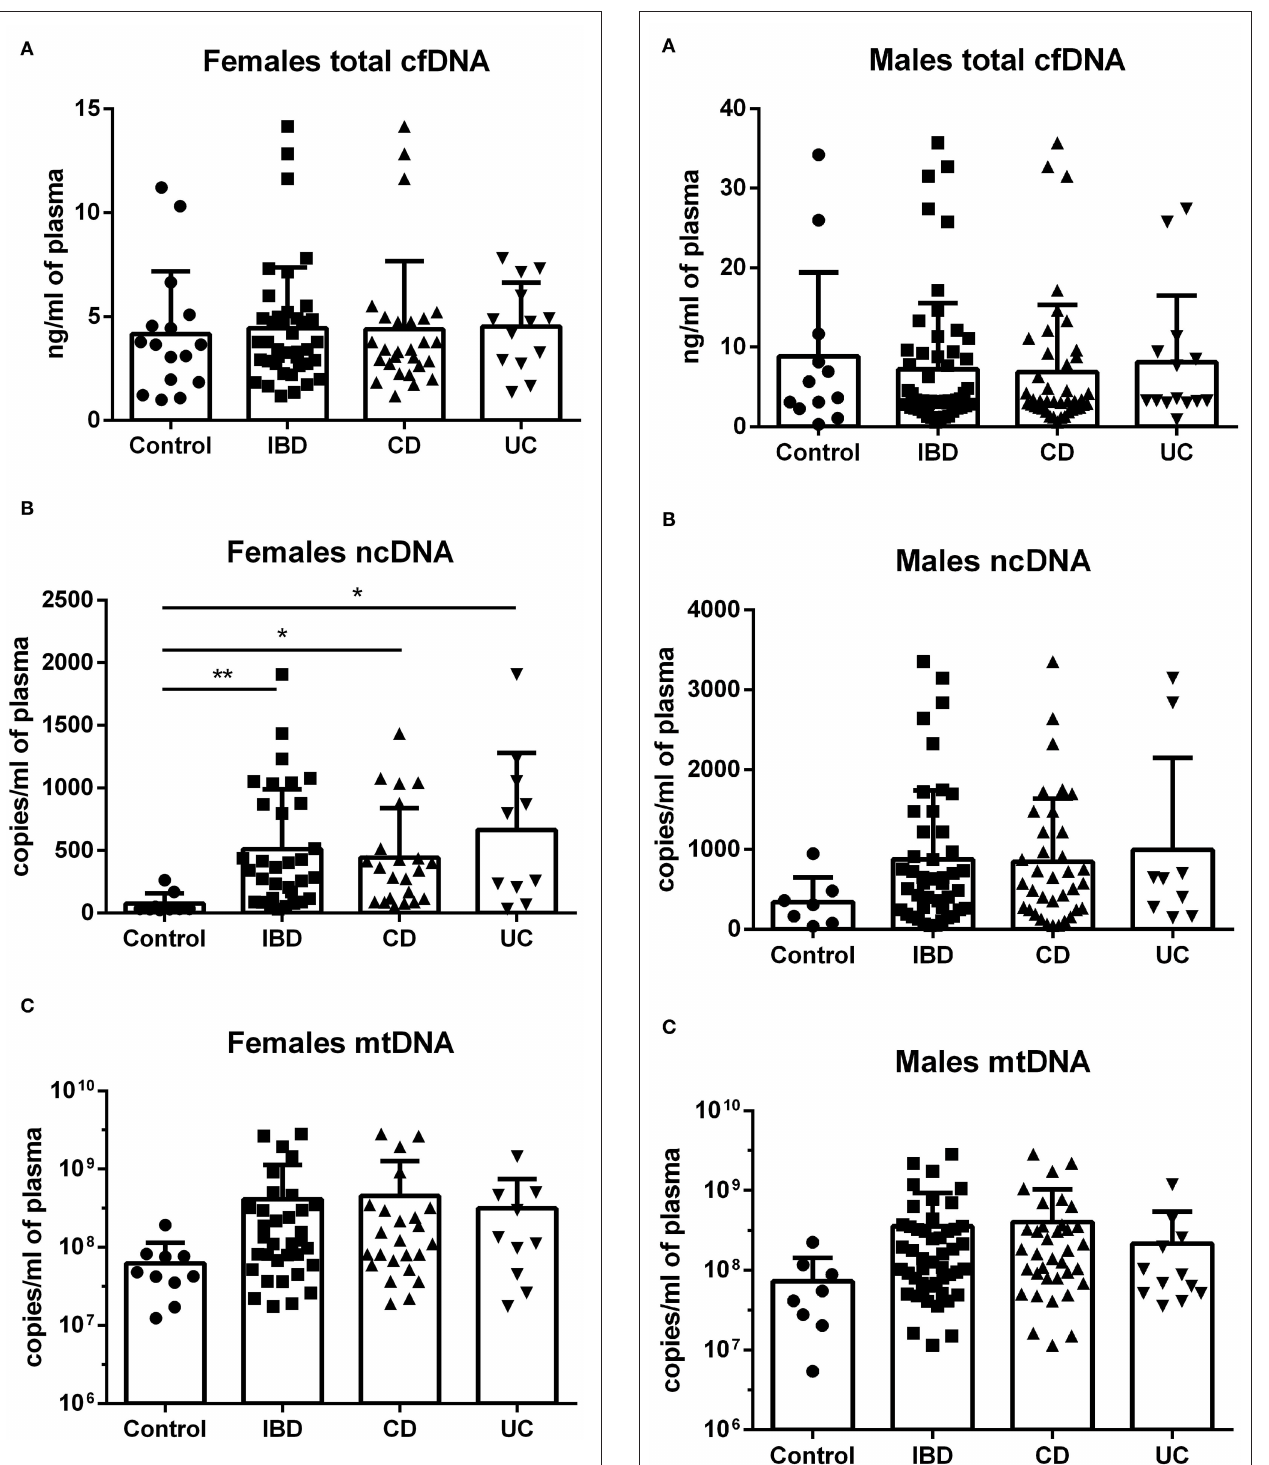
Frontiers in Medicine |